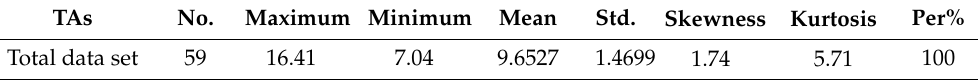
Table 1. Statistical descriptions for the arsenic content ( µ g / g) and the soil sample percentages.